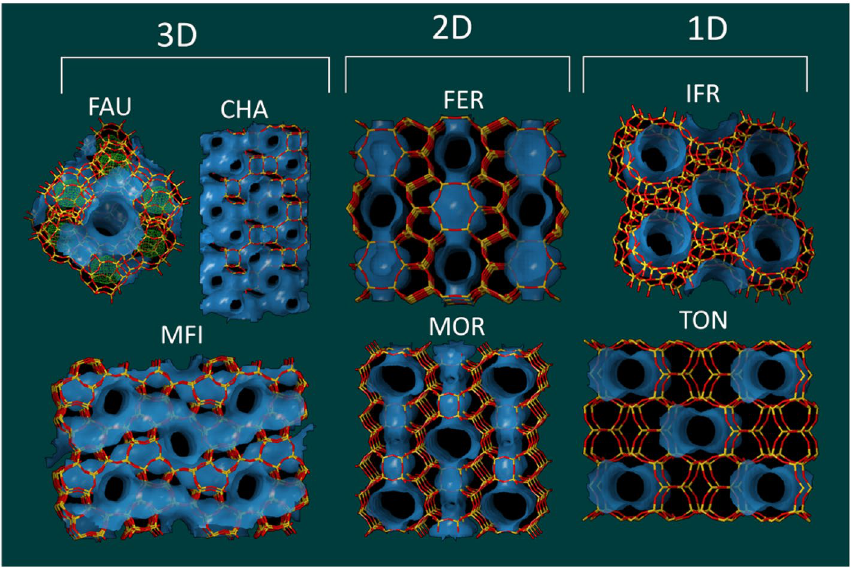
Figure 2. Structure and topology of investigated materials 44